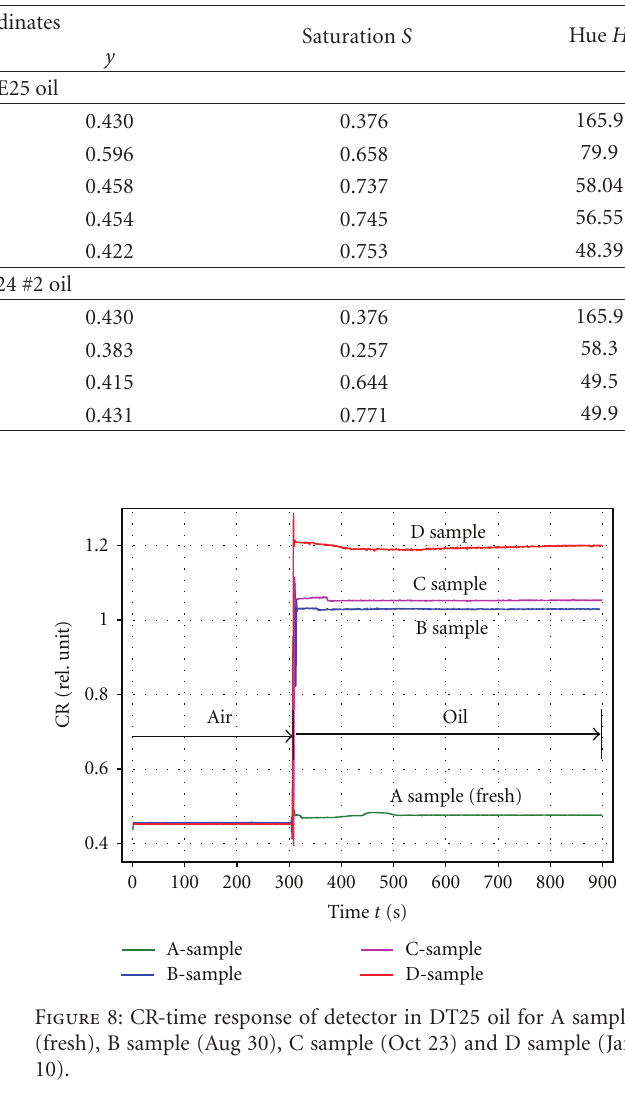
the 3 wavelengths linearly increased with particle concentra- tion in T100 samples with R 2 = 0 . 9956, 0.9925, and 0.9961 for the red, green, and blue, respectively. Standard error and sum of square residuals for the regressions were 0.0284, 0.0273, 0.0361 and 0.0073, 0.0067, 0.0117 for the red, green, and blue wavelengths, respectively. Using one-tail t - test, the P value of this regression was P value = 3 . 294 × 10 − 12 , 1 . 917 × 10 − 12 and 3 . 519 × 10 − 11 for the red, green and blue waveband respectively; that is a statistical significance of 3 . 294 × 10 − 10 %, 1 . 917 × 10 − 10 %, and 3 . 519 × 10 − 9 % in the red, green, and blue wavelength correspondingly. Hence, the null hypothesis of TCI independence on physical or particulate contamination in oil is therefore rejected based on less than 0.001% highly statistical significance. In the thermally degraded T100 samples, TCI increased linearly with increasing ageing time as shown in Figure